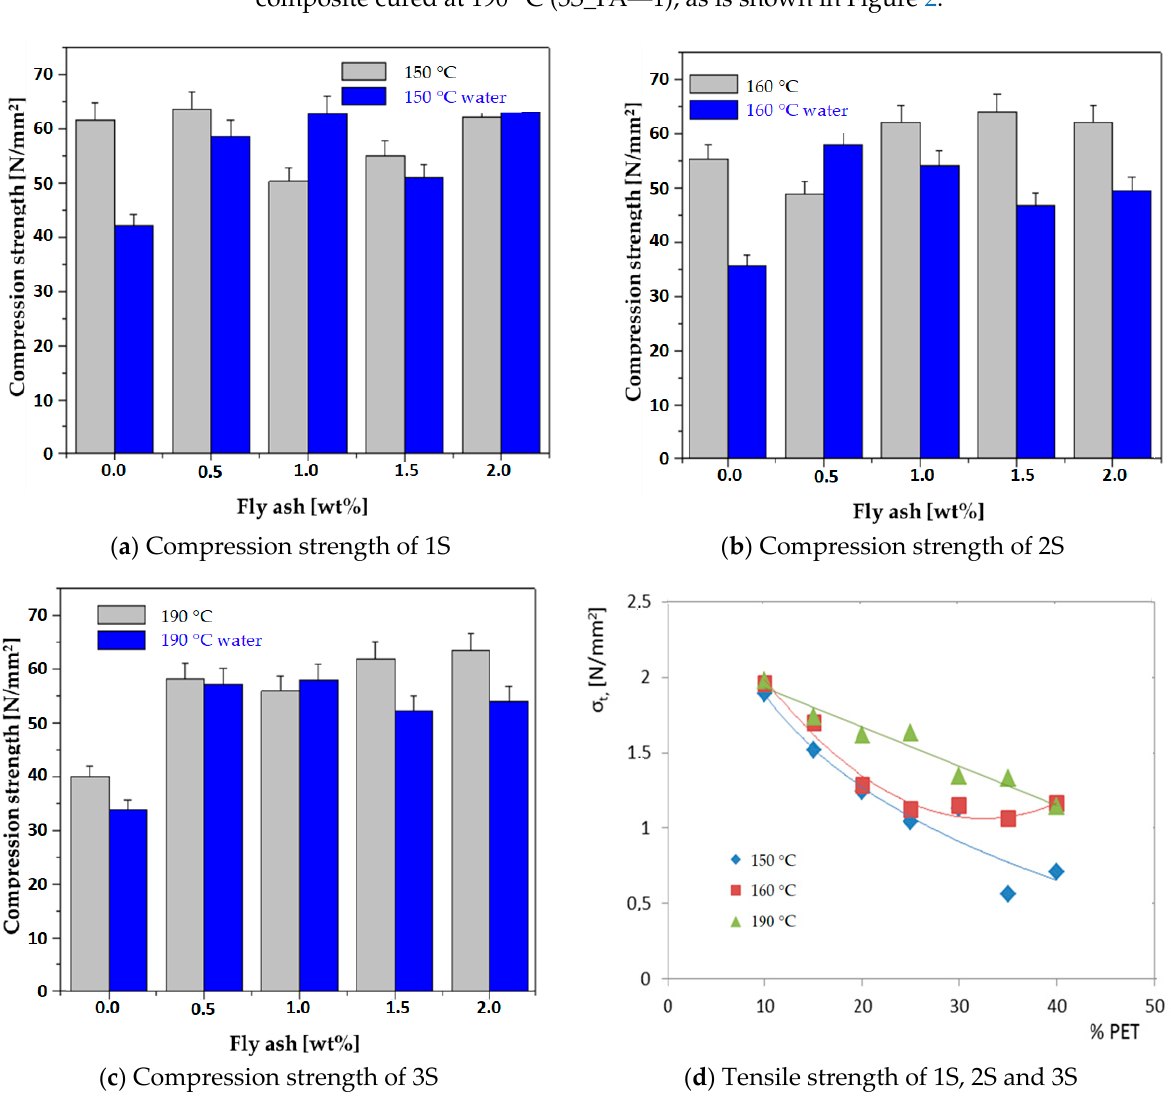
Figure 2. Mechanical properties of all waste composites before and after water immersion.